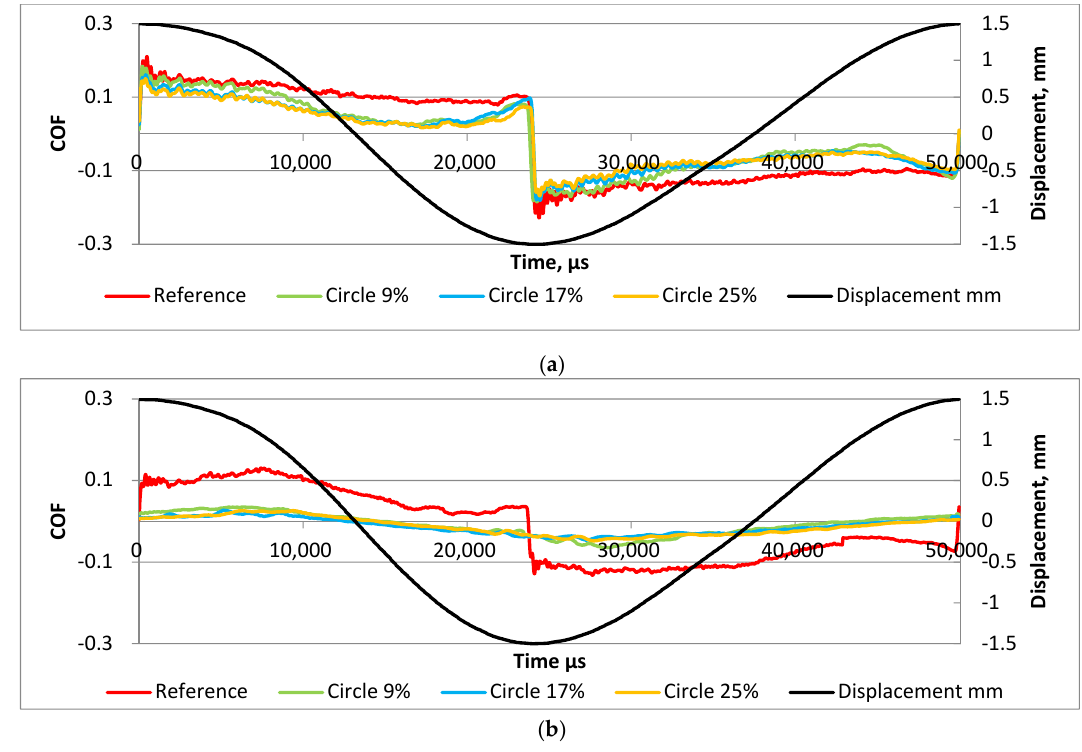
Figure 8. Coefficient of friction versus time within one stroke under the following operating conditions: f = 20 Hz; F = 40 N; T = 80 °C ( a ) and f =20 Hz; F = 40 N; T = 30 °C ( b ) .